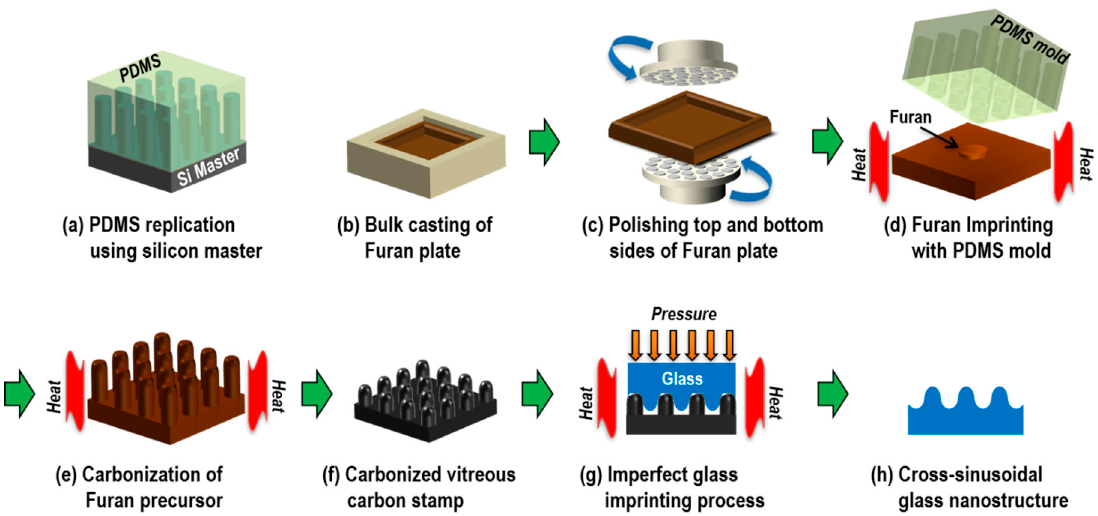
Figure 1. Schematic of the fabrication process for anti-reflective (AR) glass cross-sinusoidal nanostructure via imperfect glass imprinting using a high aspect ratio (HAR) nano-pin array (NPA) vitreous carbon (VC) stamp obtained by the carbonization of a Furan precursor. 2. Fabrication of Vitreous Carbon (VC) Stamp with a High Aspect Ratio (HAR) Nano-Pin Array (NPA) To fabricate the cross-sinusoidal AR nanostructure on a glass substrate via the imperfect glass imprinting process, a VC nanostamp with a HAR NPA was fabricated by the carbonization of an imprinted Furan precursor, as shown in Figure 1a–f. Figure 2 presents the images (top) and scanning electron microscope (SEM) images (middle: top-view, bottom: cross-sectional view) of the fabricated samples at each processing step.